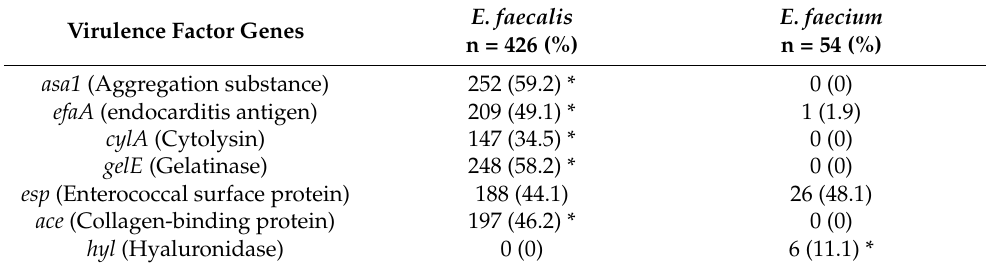
Table 1. Prevalence of virulence factors in clinical isolates of E. faecalis (n = 426) and E. faecium (n = 54). E. Virulence Factor Genes